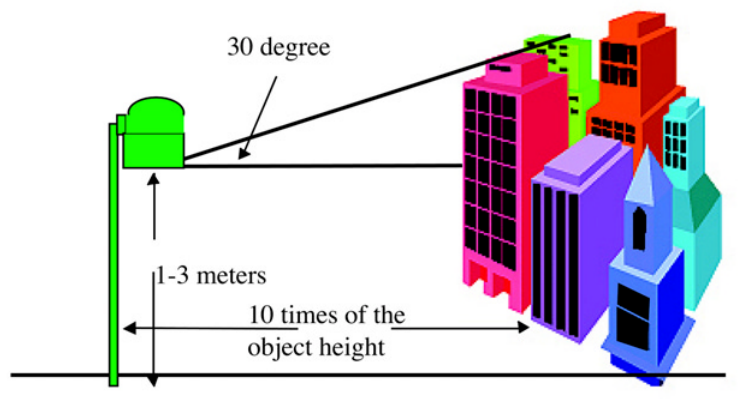
FIGURE 8. Illustration of passive installation